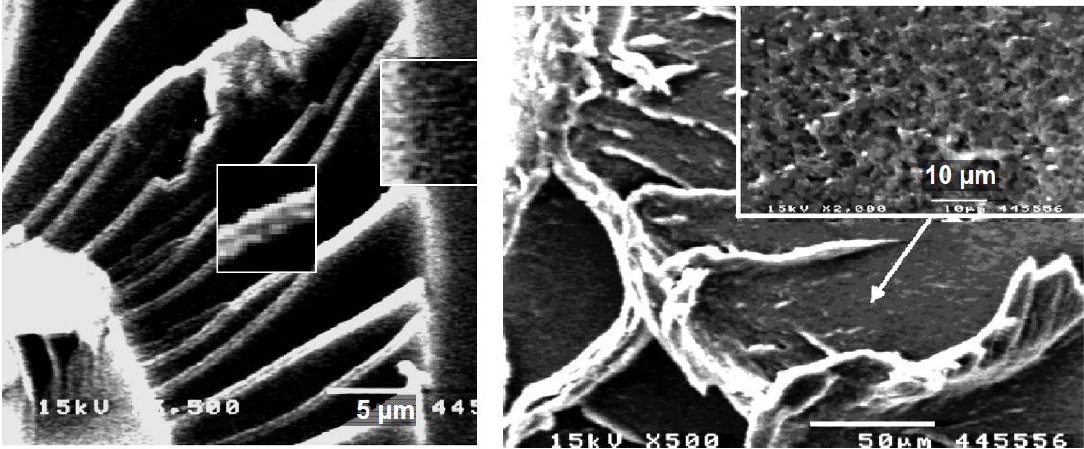
Figure 2. Scanning electron micrographs of the fractured ternary microgel particles of PEtOx/PNIPAM/PHEMA, showing 5−10 µm large channels built of aggregated microparticles (left) and porous channel walls (right) [43], reproduced by permission of the American Chemical